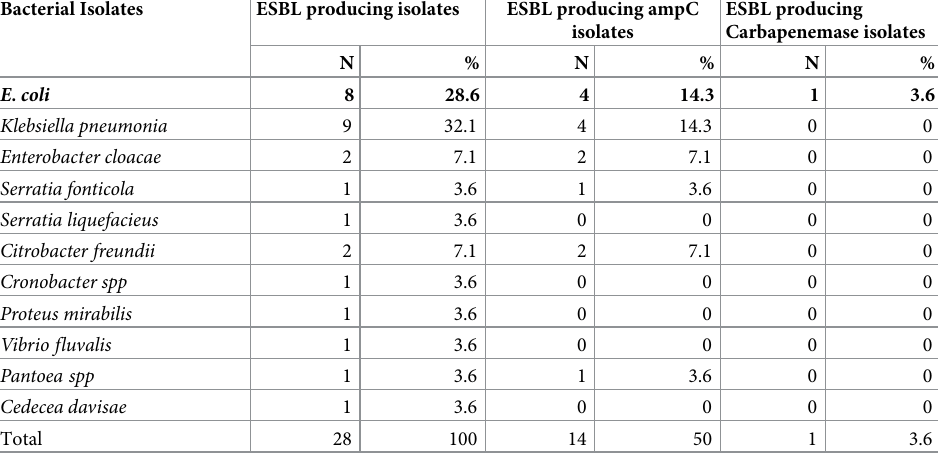
Table 3. Distribution of the species of ESBL producing Enterobacteriaceae among food handlers in West Coast Region. Bacterial Isolates